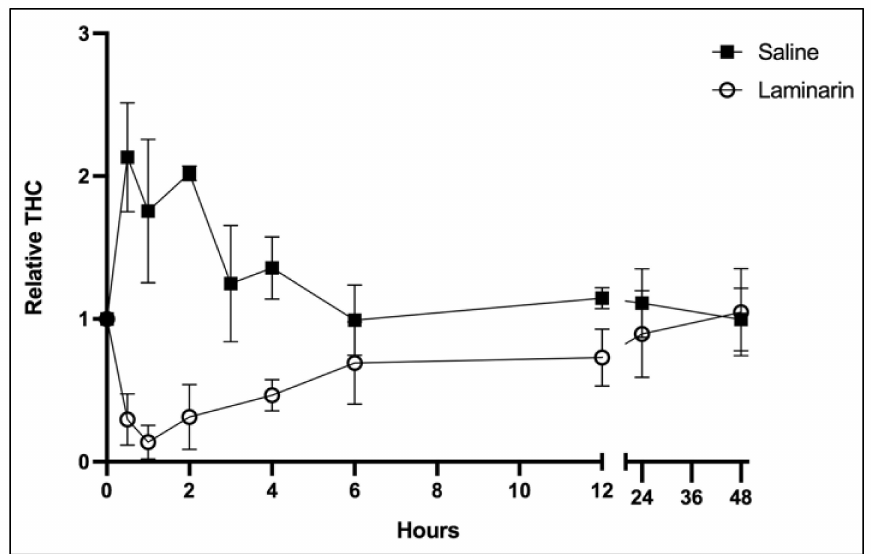
Figure 2. Changes in total hemocyte number (THC) freely circulating after saline or laminarin injection relative to values before injection. Each dot represents the mean and standard deviation and the number of animals at each time point (N) were